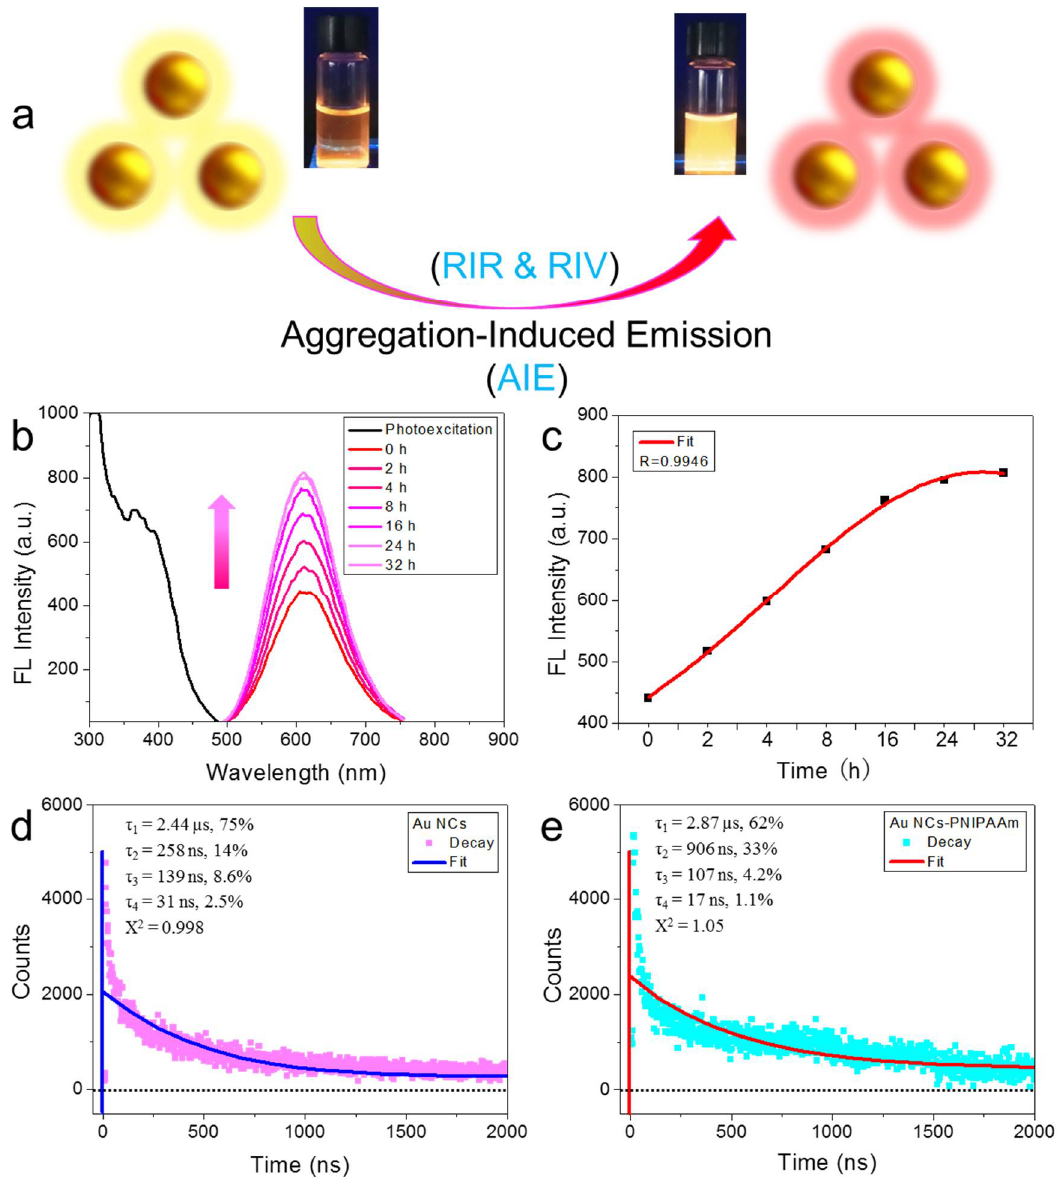
Figure 2. ( a ) Schematic illustration of the proposed mechanism for aggregation-induced emission (AIE), restriction of intramolecular rotation (RIR), and restriction of intramolecular vibration (RIV). ( b ) (Red lines) Photoemission spectra of the solution with different reaction times of the coupling process (the initiation of the reaction was defined as 0 h). (Black line) Photoexcitation spectra of Au NCs-PNIPAAm after 0 h of the coupling reaction. The excitation wavelength of the photoemission spectra is 400 nm and the emission wavelength of the photoexcitation spectrum is 620 nm. ( c ) The relationship between the luminescence intensity and the coupling time. ( d , e ) Photoluminescence decay profiles of the luminescent Au NCs and the as-synthesized Au NCs-PNIPAAm in water (0–2000